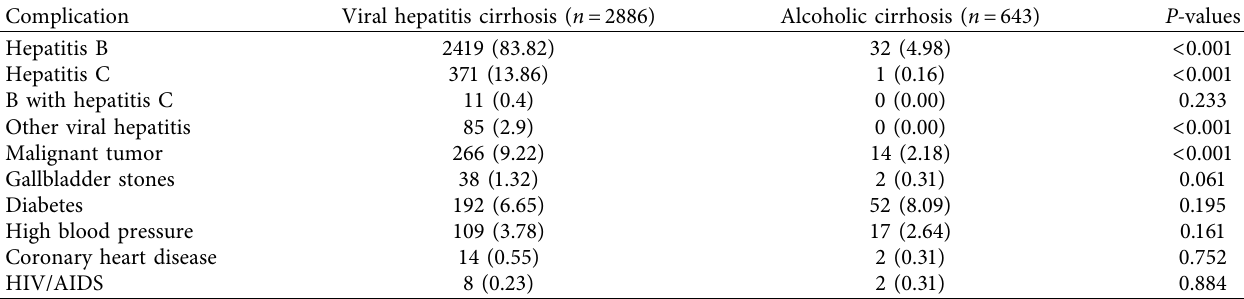
Table 1: Complications and proportion of cirrhosis in two groups [cases (%)].